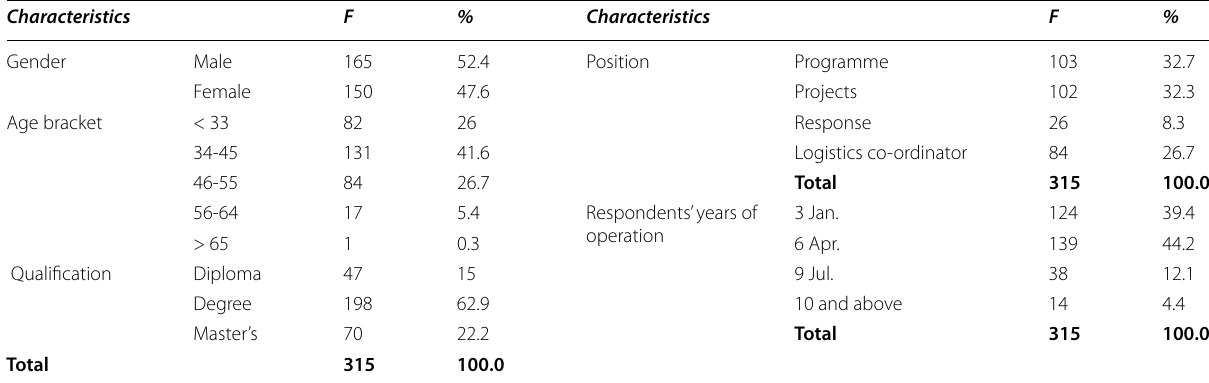
Source : Analysis of quantitative data Table 10 Direct hypothesis